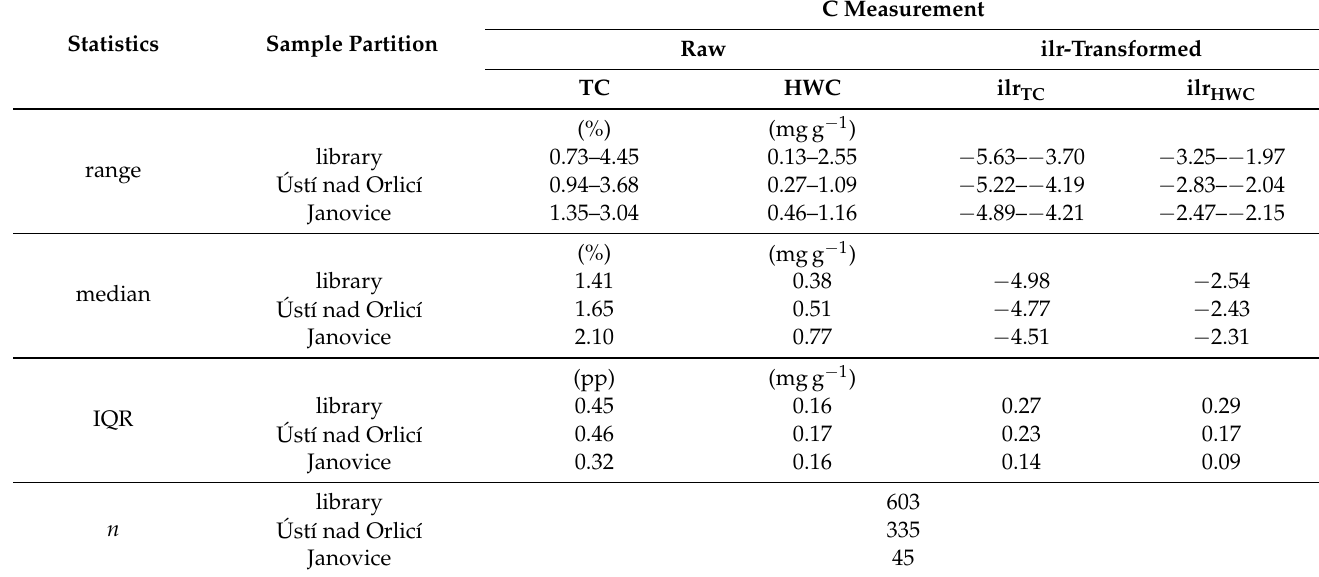
Table 2. Location and scale statistics describing the distributions of soil carbon (SC) measurements before and after isometric log-ratio (ilr)